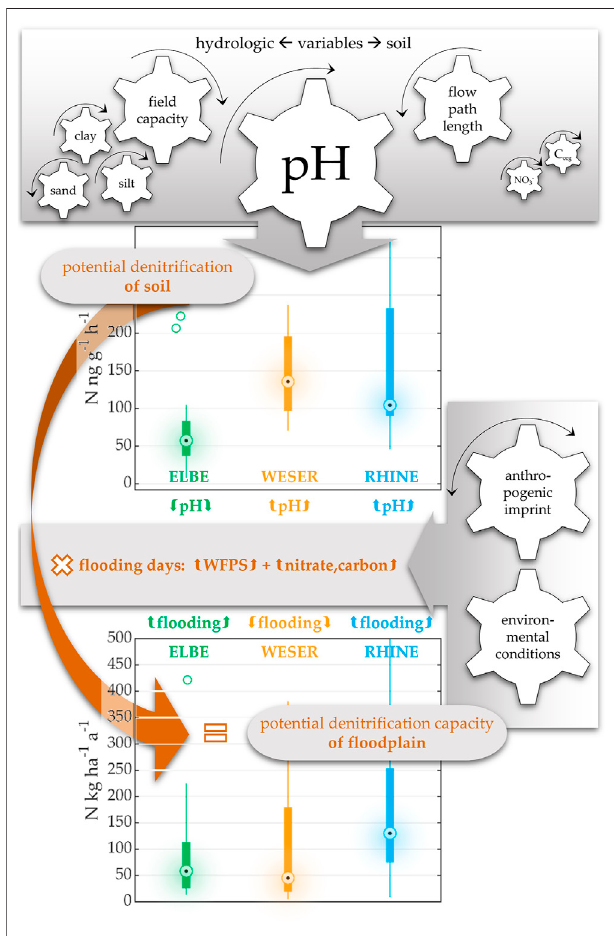
FIGURE 7 | Flowchart of this study ’ s data processing. The gears are to represent an in fl uence. If the arrow goes to the right ( “ turn up ” ), meaning a positive correlation - and the other way around. The focus is on how this calculation creates a completely changed pattern. By incorporating average inundation duration per year, potential denitri fi cation of soil is converted to potential denitri fi cation capacity of fl oodplain.